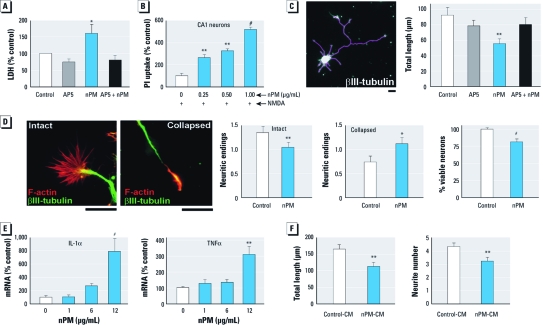
Aqueous suspensions of nPM caused in vitro glutamatergic
neurotoxicity and inflammatory responses. (A) In cultured rat hippocampal
slices, nPM caused glutamate-receptor–dependent neuronal damage (LDH release into
culture media), which was blocked by the NMDA receptor antagonist AP5 (1 μg/mL nPM,
48 hr, + 50 μM AP5; n = 16 hippocampal slices per treatment). (B) nPM
increased NMDA-induced neurotoxicity (10 μM NMDA, 24 hr treatment with 24 hr
recovery). PI uptake was measured as a percentage of NMDA-treated slices (n =
5 slices per treatment). (C) In primary E18 neuronal cultures, nPM treatment
reduced neurite outgrowth; left, representative image used to measure the length of
neurites (bar = 20 μm); right, exposure to nPM (2 μg/mL, 48 hr) decreased the total
length of neurites by 40% (n = 50 neurons per treatment). The inhibition of
neurite extension was rescued by the glutamate receptor antagonist AP5 (50 μM).
(D) In primary neuron cultures, nPM caused > 50% of growth cones
to collapse (n = 90 neurons per treatment). Intact growth cones retain
actin-rich (red) neuritic endings (filopodia and lamellipodia (representative
images; bars = 20 μm). nPM (2 μg/mL, 48 hr) decreased neuronal viability by 20%
(n = 10 culture wells per treatment). (E) In mixed glial cultures,
24-hr treatment with nPM caused dose-dependent increase in mRNA levels of
inflammatory cytokines IL-1α and TNFα (n = 6 glia cultures per treatment).
(F) Conditioned medium (CM) from nPM-treated mixed glia (10 μg/mL nPM, 24
hr) inhibited neurite outgrowth by 30% and decreased the number of neurites by 25%
(n = 80 neurons per treatment). *p < 0.05, **p
< 0.01; #p < 0.001, by ANOVA (A–C, E) or
t-test (D,F), compared with control air-exposed mice